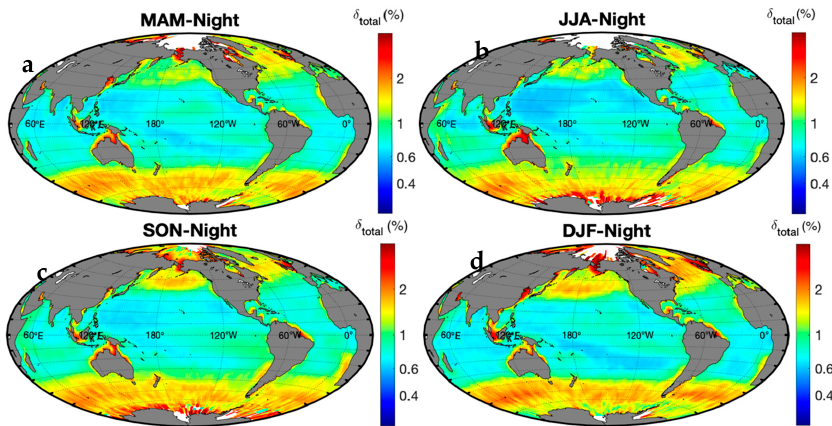
Figure 3. Seasonal distributions of CALIOP total depolarization ratio ( δ total , %) at nighttime before crosstalk correction. ( a ) March–May; ( b ) June–August; ( c ) September–November; ( d ) December– February. Data are seasonal average climatology for the 2006–2020 period and have been averaged to 1 ◦ latitude × 1 ◦ longitude pixels. Remote Sens. 2021 , 13 , x FOR PEER REVIEW